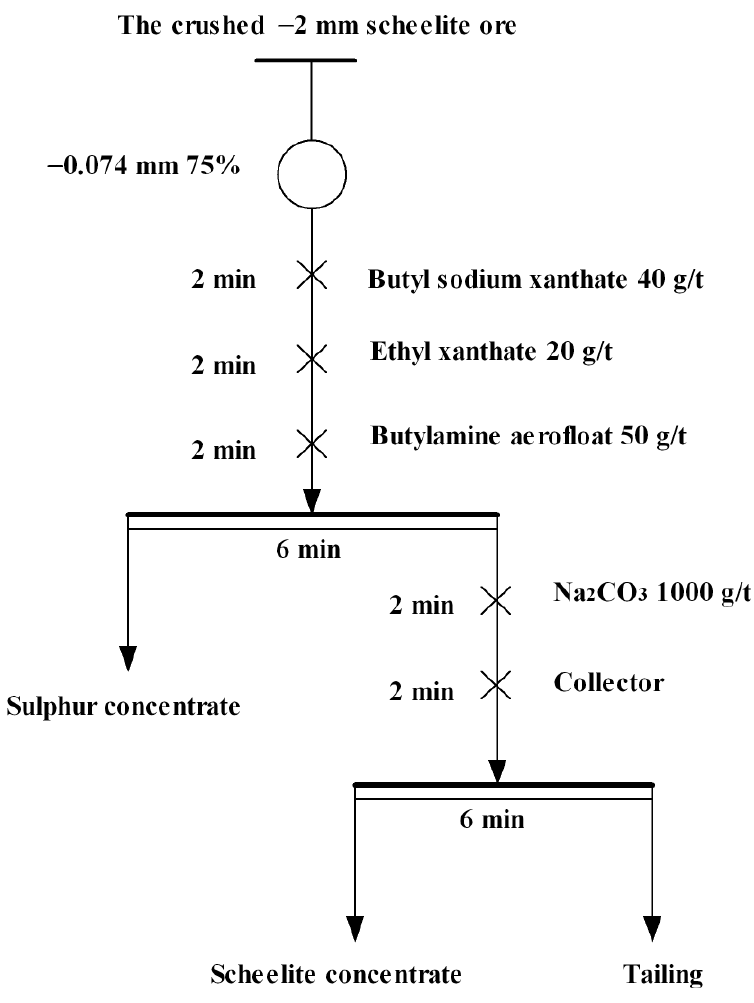
Figure 3. The flowsheet of the scheelite roughing test.